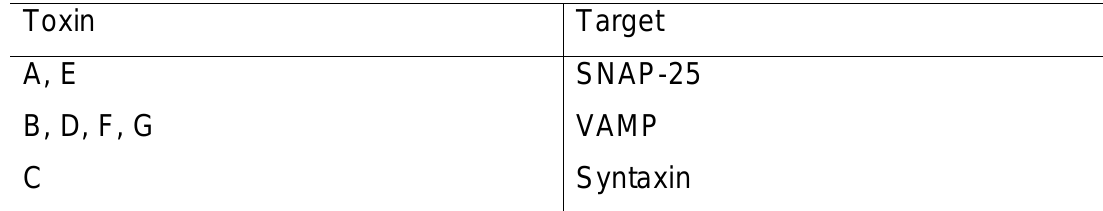
Table 3: SNARE targets of different botulinum toxin serotypes (4).